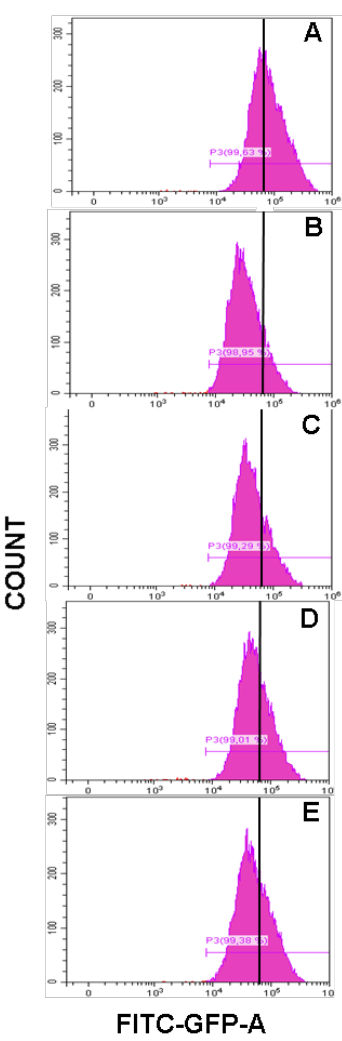
Figure 3. Representative flow-cytometry histograms corresponding to ROS generation in differentiated SH-SY5Y cells for t -BOOH treatment ( A ) and t -BOOH plus cocoa treatment at different concentrations ( B , 200 µg/mL; C , 100 µg/mL; D , 50 µg/mL; and E , 25 µg/mL).